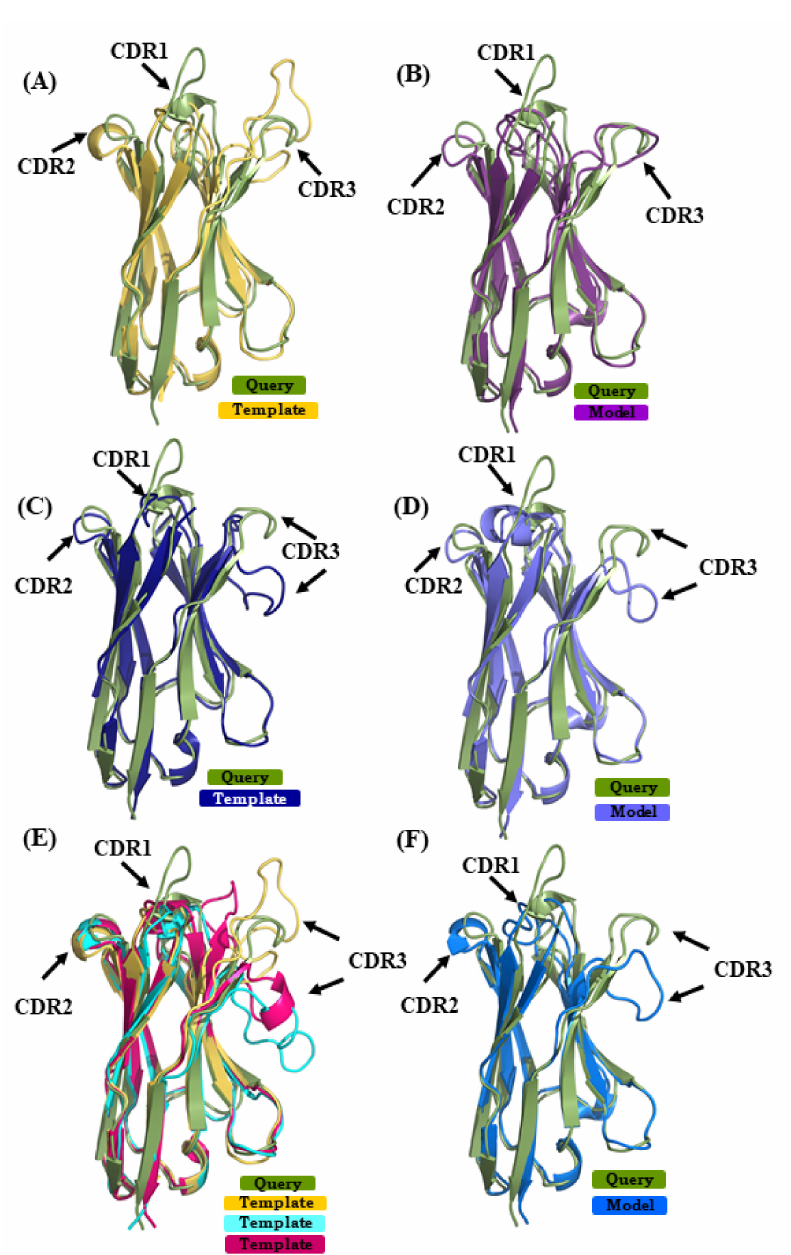
Figure 6. Superimposition of V H H query structure (V H H binding to human M2 muscarinic acetyl- choline receptor, PDB ID 4MQS:B) and templates/models. The query PDB ID 4MQS:B [33] is superimposed with templates used in ( A ) scenario 1 (in yellow PDB ID 5HDO:A [35], ( C ) in sce- nario 2 (in dark blue PDB ID 3STB:B [36], and ( E ) in addition to template from scenario 1, PDB ID 4TVS:a [37] in cyan, and in pink PDB ID 4LAJ:H [38]. ( B , D , F ) are best-selected models using templates shown in ( A ) (in purple), ( C ) (in magenta), and ( E ) (in light